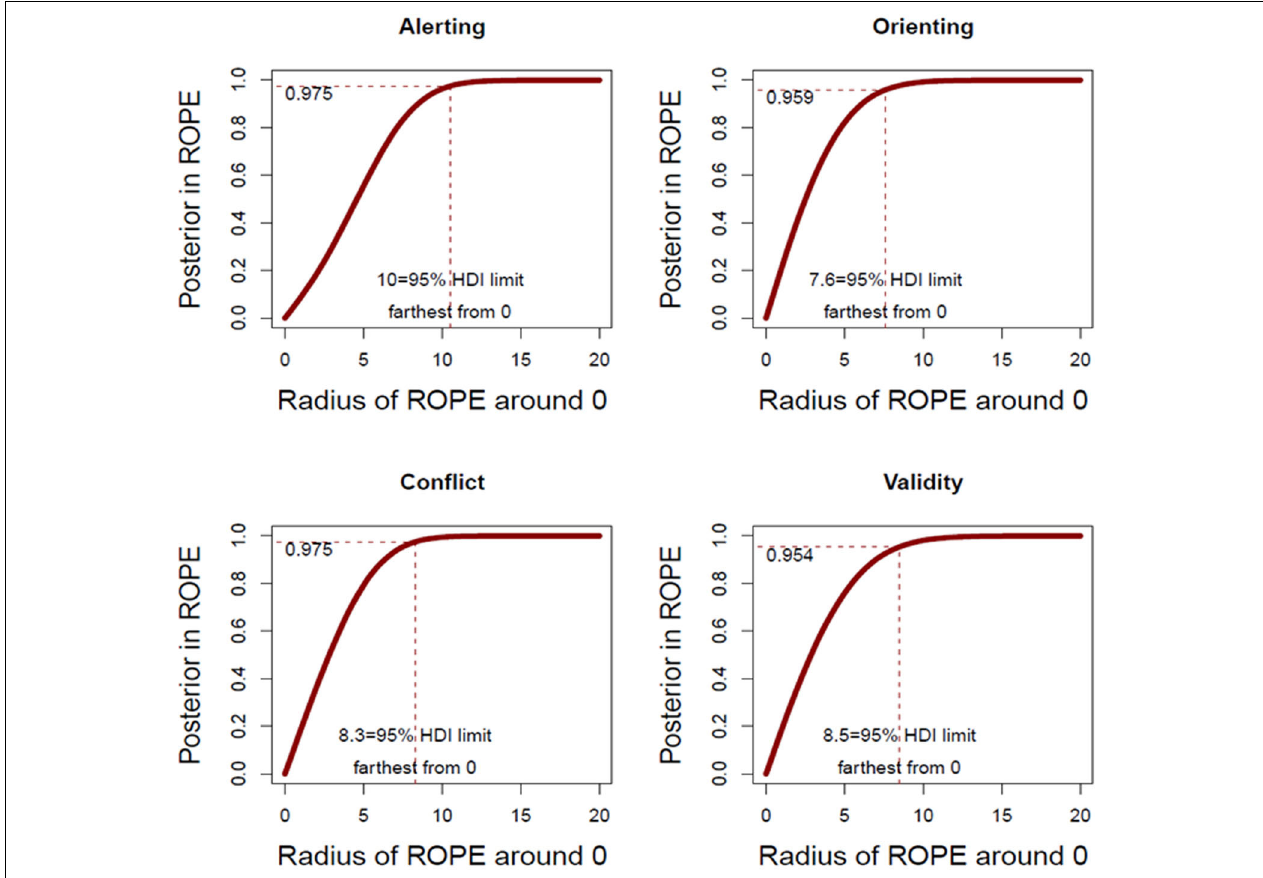
FIGURE 3 | Proportion of the posterior distribution falling within the ROPE as a function of ROPE width. X axis shows how far the ROPE limit is from 0 value (no differences). Y axis reflects the proportion of